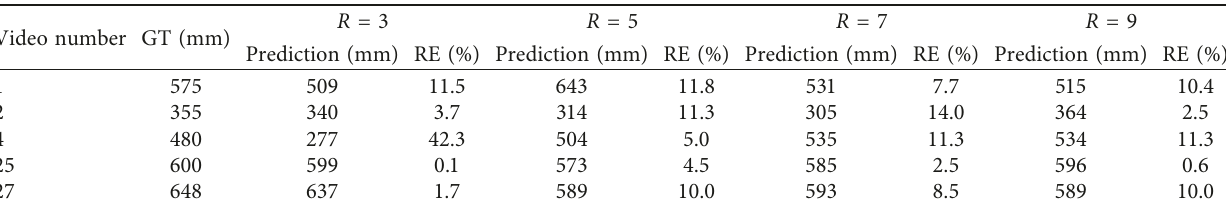
Figure 22: Prediction results of VF values with different R : (a) R � 3; (b) R � 5; (c) R � 7; (d) R � 9. Table 6: Prediction results of SF values with different R